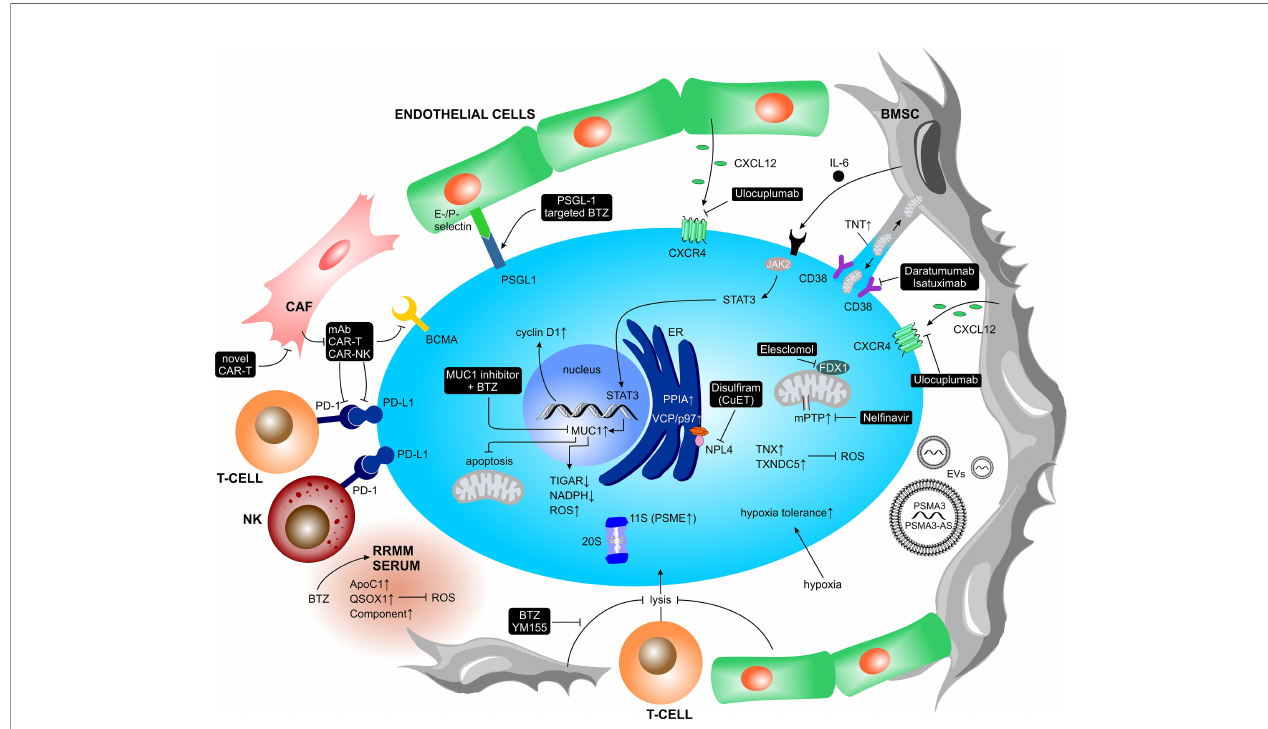
FIGURE 6 | TME-mediated PI resistance and therapeutic strategies to overcome TME-mediated PI resistance. The complex contact-dependent and contact- independent interactions of myeloma PCs with the surrounding tumor microenvironment mediate MM adaptation to PI treatment. Black boxes illustrate potential treatment strategies to overcome TME-mediated PI resistance in MM. ApoC1, apolipoprotein C1; BCMA, B-cell maturation antigen; BMSC, bone marrow stromal cell; BTZ, Bortezomib; CAF, cancer-associated fi broblast; CAR-T, chimeric antigen receptor T-cell; CAR-NK, chimeric antigen receptor natural killer cell; CXCL, C-X- C motif chemokine ligand; CXCR, C-X-C motif chemokine receptor; EC, endothelial cell; ER, endoplasmic reticulum; EV, extracellular vesicle; FDX1, ferredoxin 1; IL- 6, interleukin-6; JAK2, janus kinase 2; mAB, monoclonal antibody; mPTP, mitochondrial permeability transition pore; MUC1, mucin 1; NADP(H), nicotinamide adenine dinucleotide phosphate (reduced); NK, natural killer cell; NPL4, nuclear protein localization 4 homolog; PD-1, programmed cell death protein 1; PD-L1, programmed cell death 1 ligand 1; PPIA, peptidylprolyl isomerase A; PSGL-1, P-selectin glycoprotein ligand-1; PSMA3, proteasome 20S subunit alpha 3; PSMA-AS1, PSMA3 antisense RNA 1; PSME, proteasome activator subunit; QSOX1, quiescin sulfhydryl oxidase 1; ROS, reactive oxygen species; STAT3, signal transducer and activator of transcription 3; TIGAR, p53-inducible regulator of glycolysis and apoptosis; TNT, tunneling nanotubes; TNX, thioredoxin; TXNDC5, thioredoxin domain-containing protein